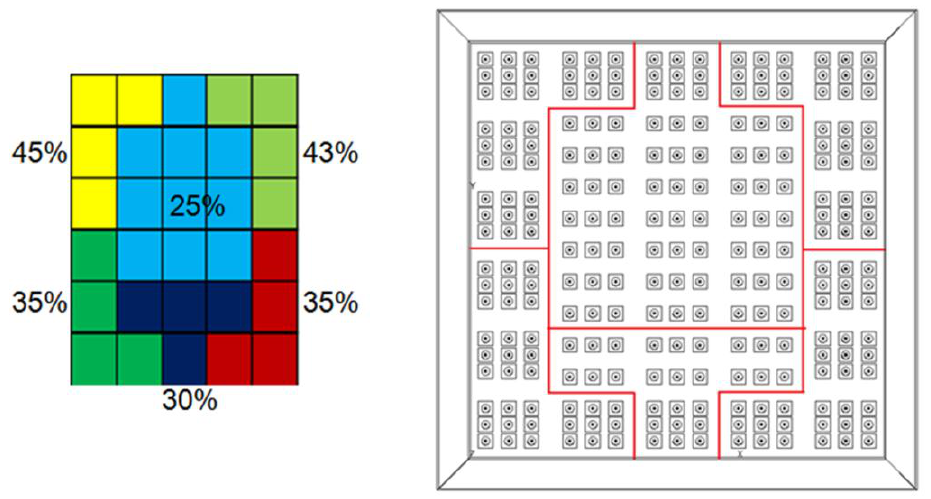
Figure 26. LED power distribution: type 2.